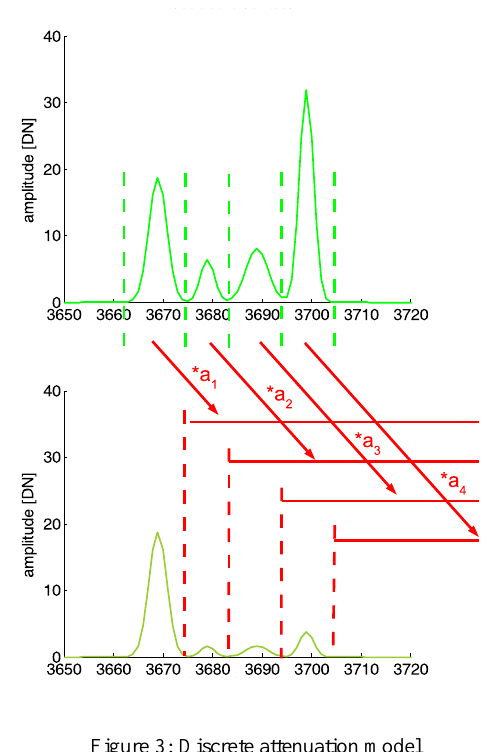
Figure 3: Discrete attenuation model